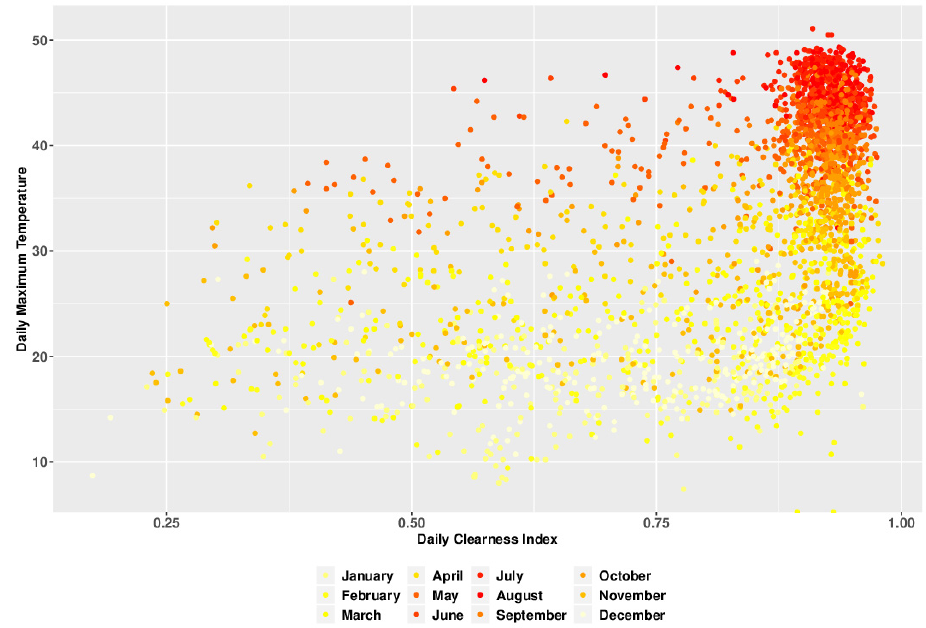
Figure 5. Scatter plot illustrating correlation between Daily Clearness Index ( K t ) and Daily Maximum Temperature at Abraq Mazraa (°C) for 2007–2017.